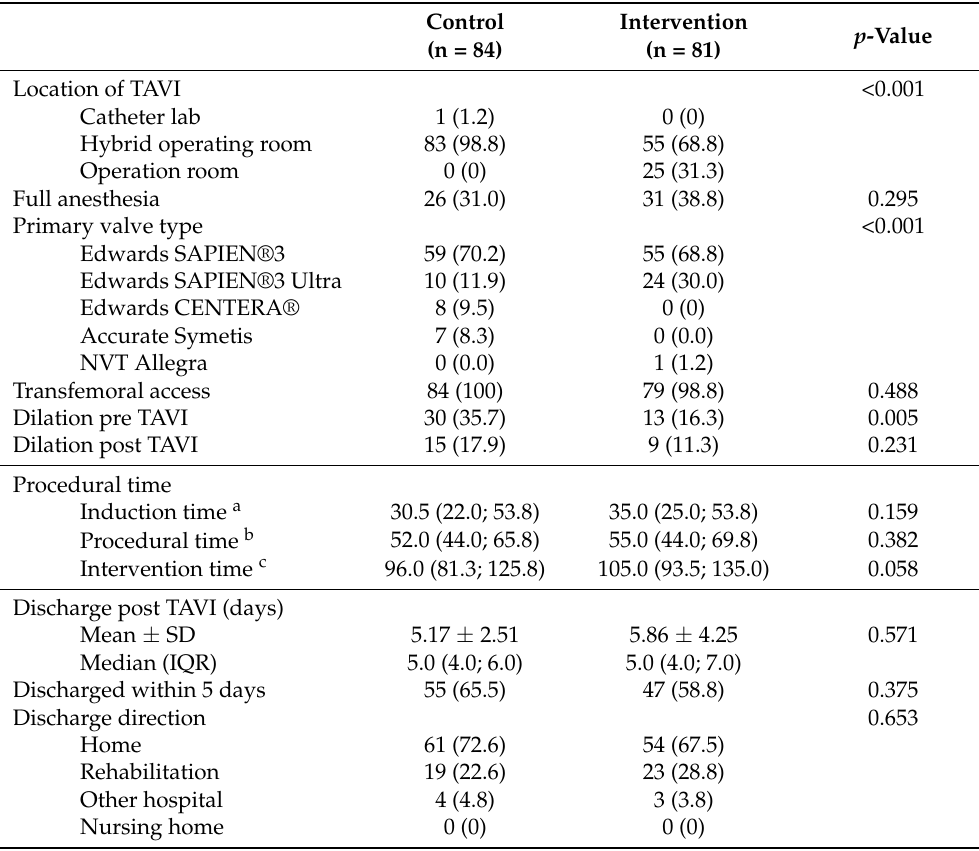
Table 3. Procedural characteristics prior to (control phase) and after implementation of the TAVI coordinator (intervention